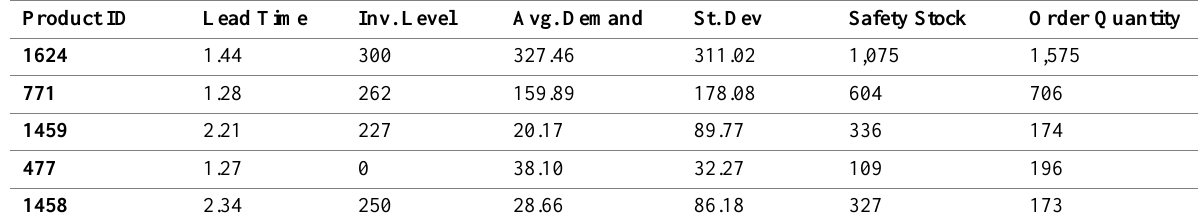
Table 3: Result Example of Safety Stock and Order Quantity based on Fixed-time